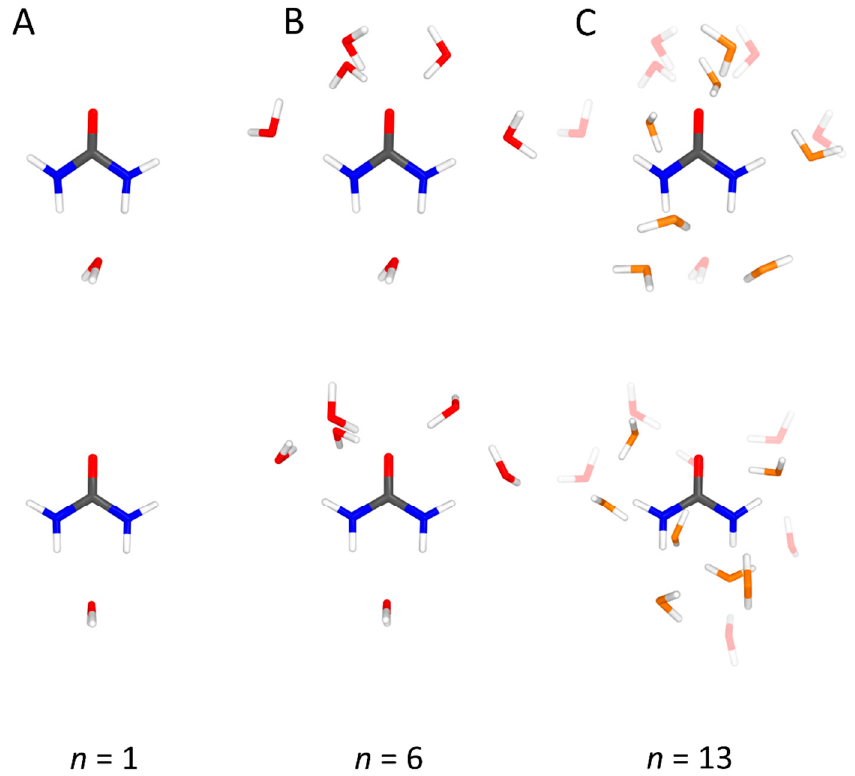
Figure 4. Representation of the urea–(H 2 O) n complexes before (upper row) and after (lower row) quantum chemical optimization with B3LYP/def2-TZVP/D3 in implicit solvent, with n = 1 ( A ), n = 6 ( B ), and n = 13 ( C ) water molecules. The six water molecules with the lowest ∆ A value are colored in red, while the additional seven water molecules in the urea–(H 2 O) 13 complex are colored in orange.